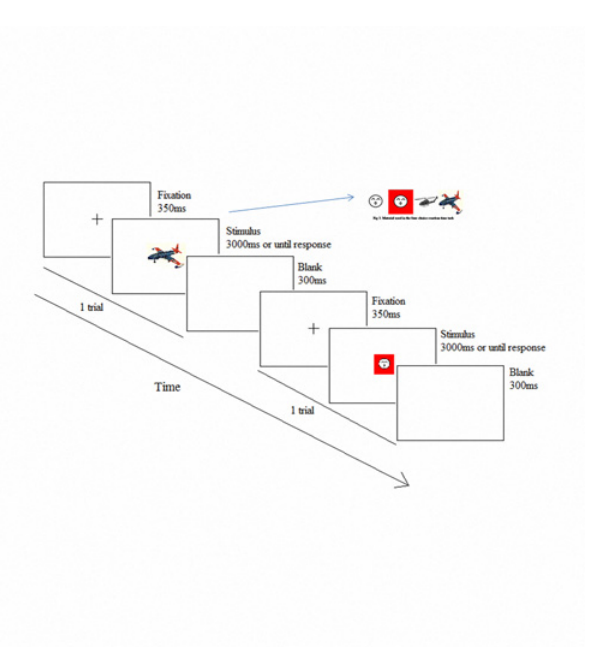
Fig 2. Four-choice RT task procedures. First, a fixation point was presented for 350 ms. Then, each stimulus was presented for 3,000 ms. Participants were required to press the keys as soon as possible. The minimum ISI was 300